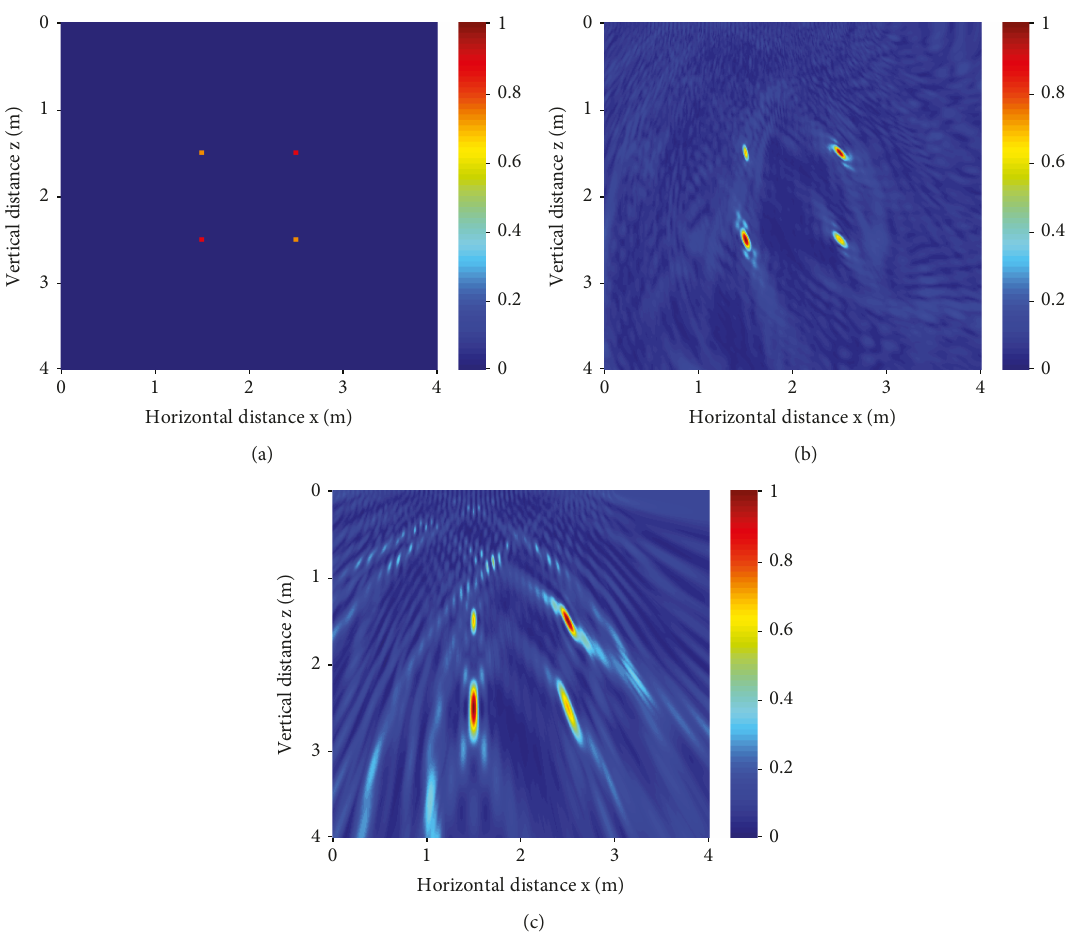
Figure 6: Two strong target and two weak target detection: (a) actual position of target, (b) FDA-MIMO radar, and (c) conventional MIMO radar.